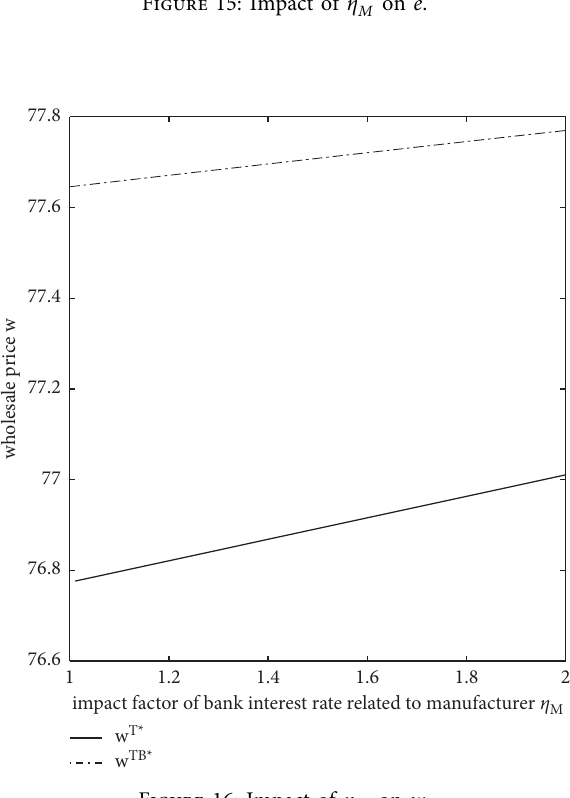
Figure 15: Impact of η